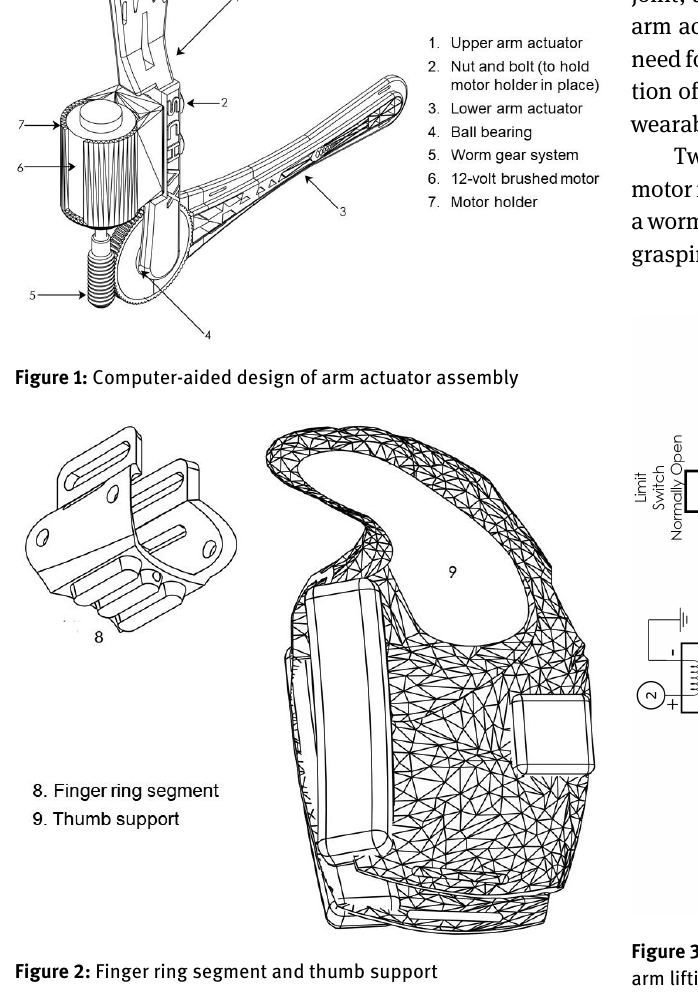
Figure 2: Finger ring segment and thumb support